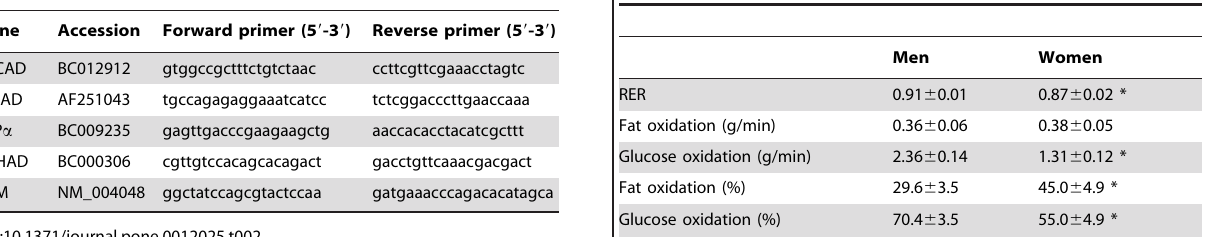
Table 3. Substrate oxidation in men and women cycling at 65% VO 2peak .